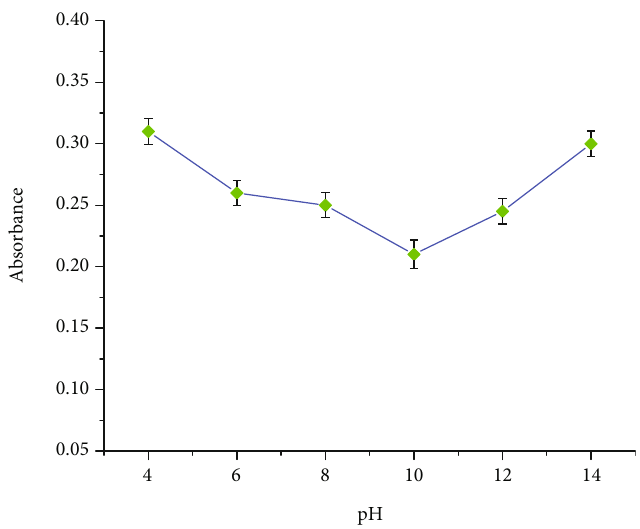
Figure 12: Stability of ACR-AgNPs complex with Hg 2+ in the pH range of 1-14. Table 1: Results for the detection of Hg 2+ in D.I water and tap water samples ( mean ± SD , n = 3